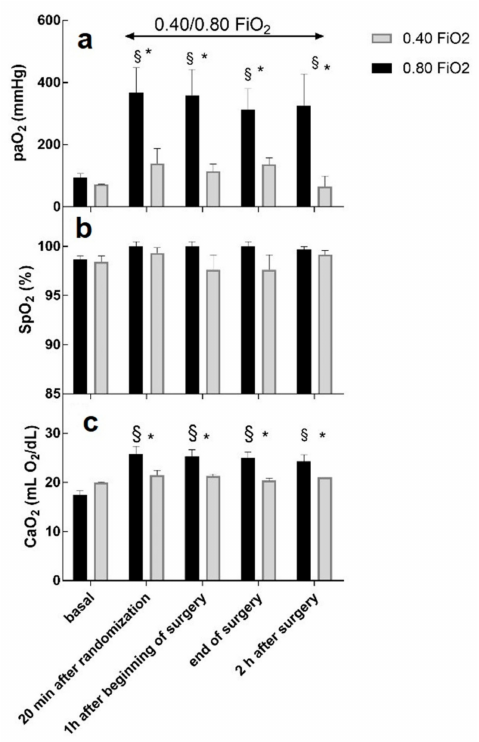
Figure 2. Time course of PaO 2 ( a ), SpO 2 ( b ), and CaO 2 ( c ) during the experimental protocol. Data are expressed as mean ± standard error of the mean (SEM). § p < 0.05 when compared to basal value (two-way ANOVA test, Dunnett’s method); * p < 0.05 FiO 2 = 0.40 vs. 0.80 (Student’s t